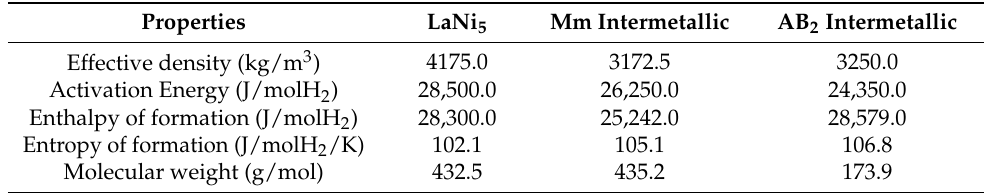
Table 2. Main properties of the metal